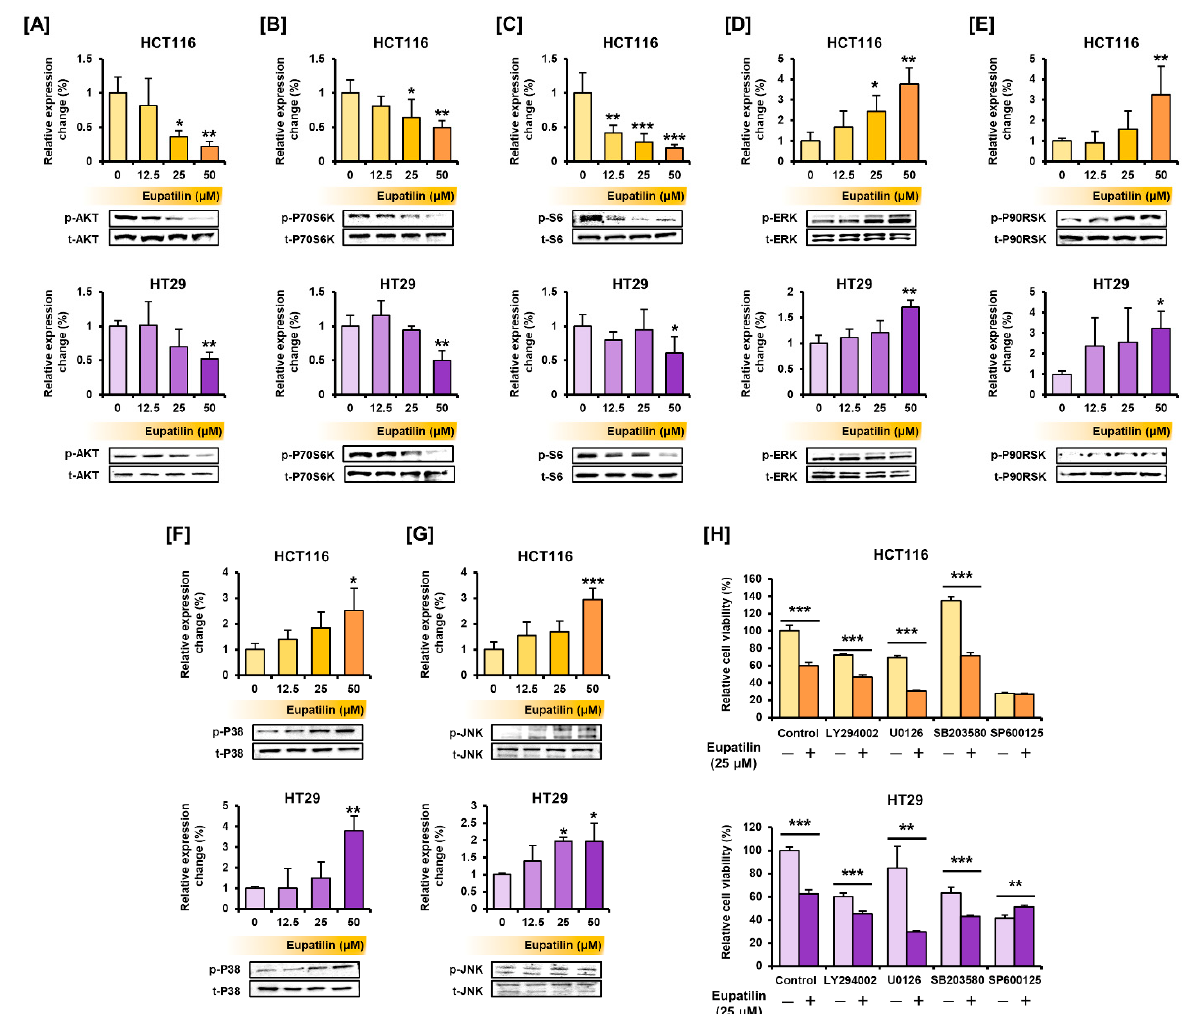
Figure 4. Regulation of PI3K/AKT and MAPK signaling pathways by eupatilin in colon cancer cells. ( A – G ) Phosphorylated AKT ( A ), P70S6K ( B ), S6 ( C ), ERK ( D ), P90RSK ( E ), P38 ( F ), and JNK ( G ). Immunoblots were quantitated to calculate the normalized values by estimation of expressed levels from phosphorylated proteins relative to total proteins. ( H ) Effects of eupatilin and selective inhibitors for AKT (LY294002), ERK (U0126), P38 (SB203580), and JNK (SP600125) on HCT116 and HT29 cell viability. Data are presented as a percentage relative to control (100%). Asterisks indicate a significant change after eupatilin treatment (*** p < 0.001, ** p < 0.01, and * p < 0.05).